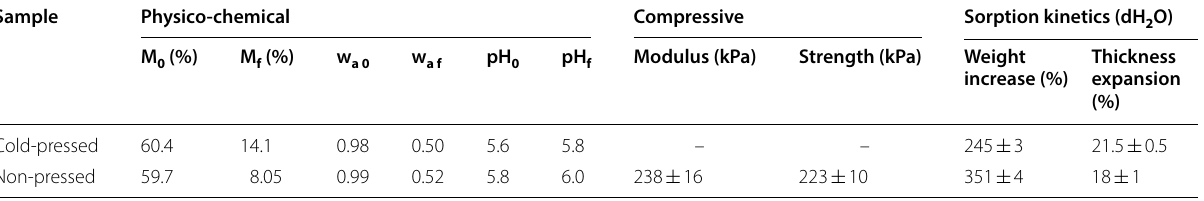
Table 2 Physico-chemical, compressive, and sorption kinetic properties of the mycelium-based composites studied Sample